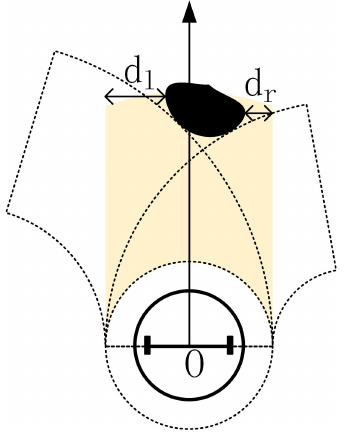
Figure 10. There is an obstacle in area D